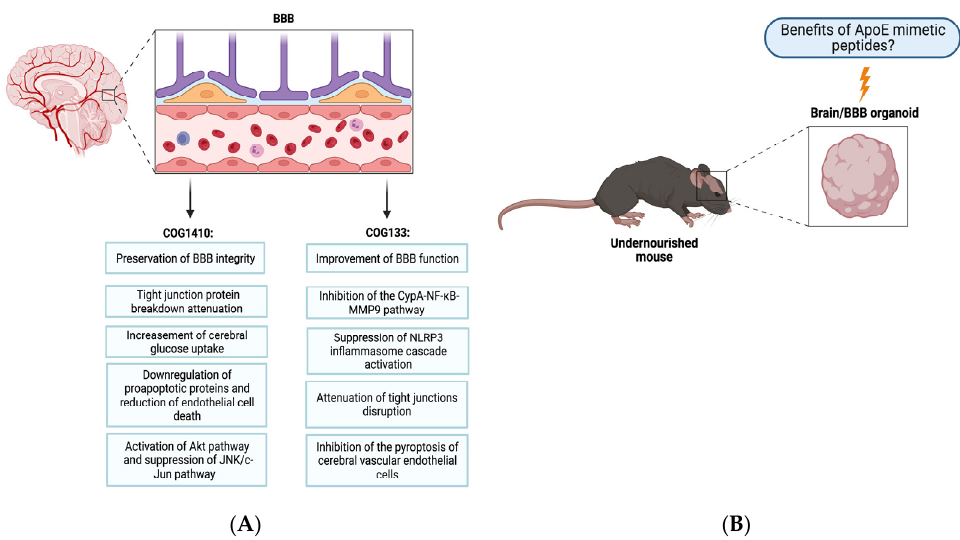
Figure 4. ( A ) Summary of apoE mimetic peptides bene fi cial e ff ects on the blood-brain barrier (BBB) in models of brain injury. ( B ) The assessment of novel in vitro models of BBB and brain organoids may help to elucidate whether selected apoE peptides could be beneficial in preserving the gut-brain axis of mice a ffl icted with malnutrition/enteric infections. Figure created with BioRender.com.